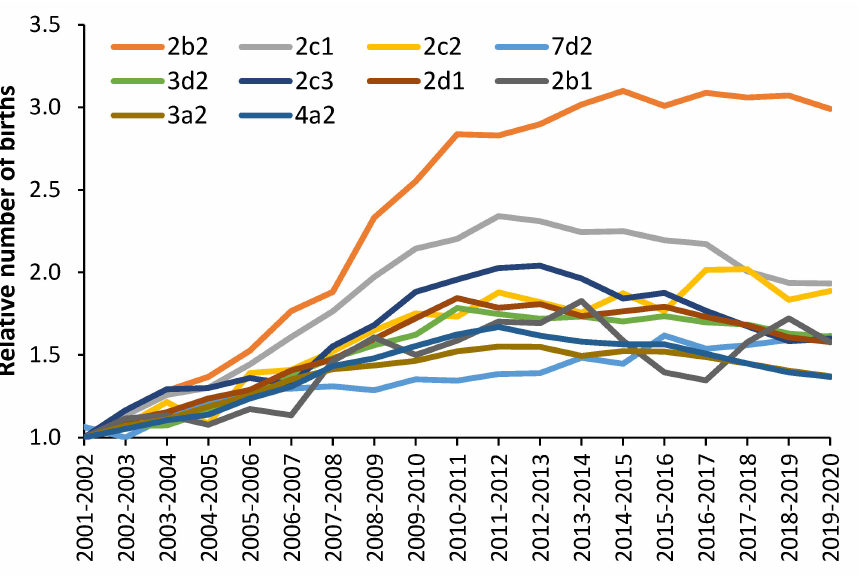
Figure A4. Trends in annual births by social group. Data are from the Office for National Statis- tics